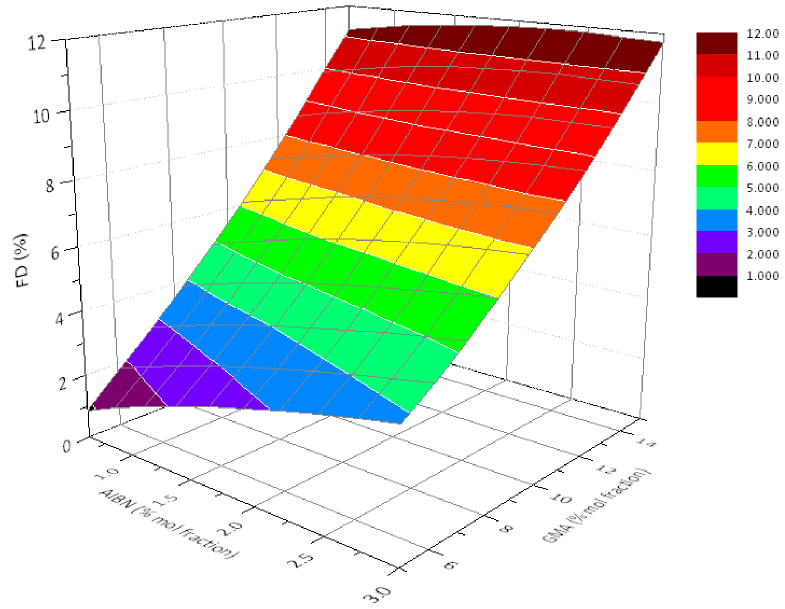
Figure 5. 3D plot of model for FD from synthesis of PCL- g -GMA in scCO 2.